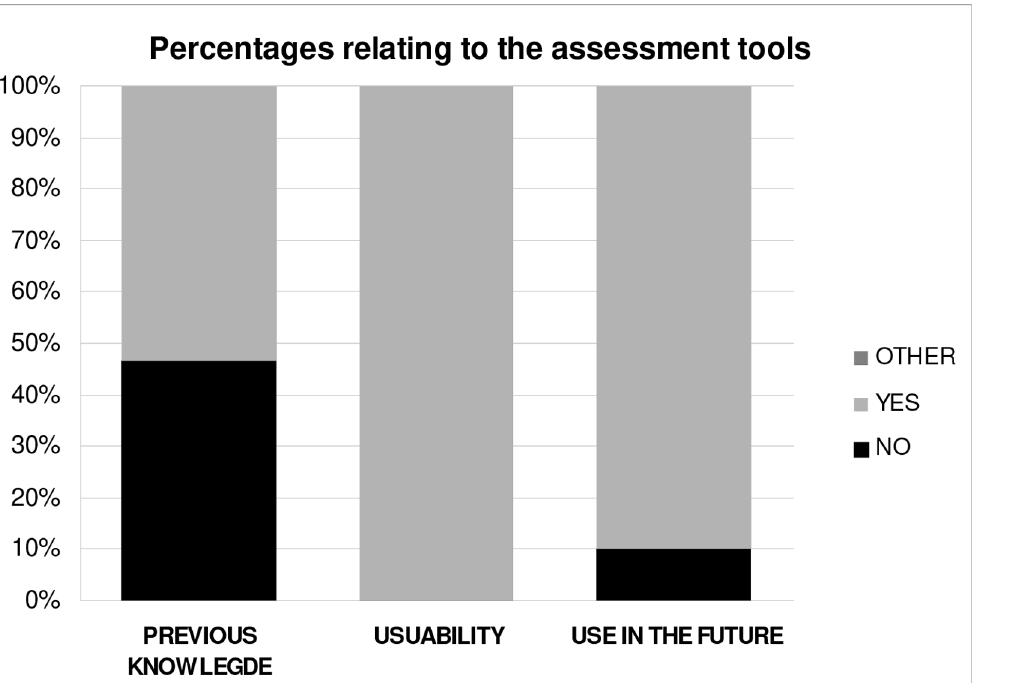
Fig 8. Percentages relating to the clinical assessment tools. Among respondents who would apply these tools, 33.3% would do for teaching, 37.5% in hospitals, 54.2% in dietetic consultation and 16.7% in research.